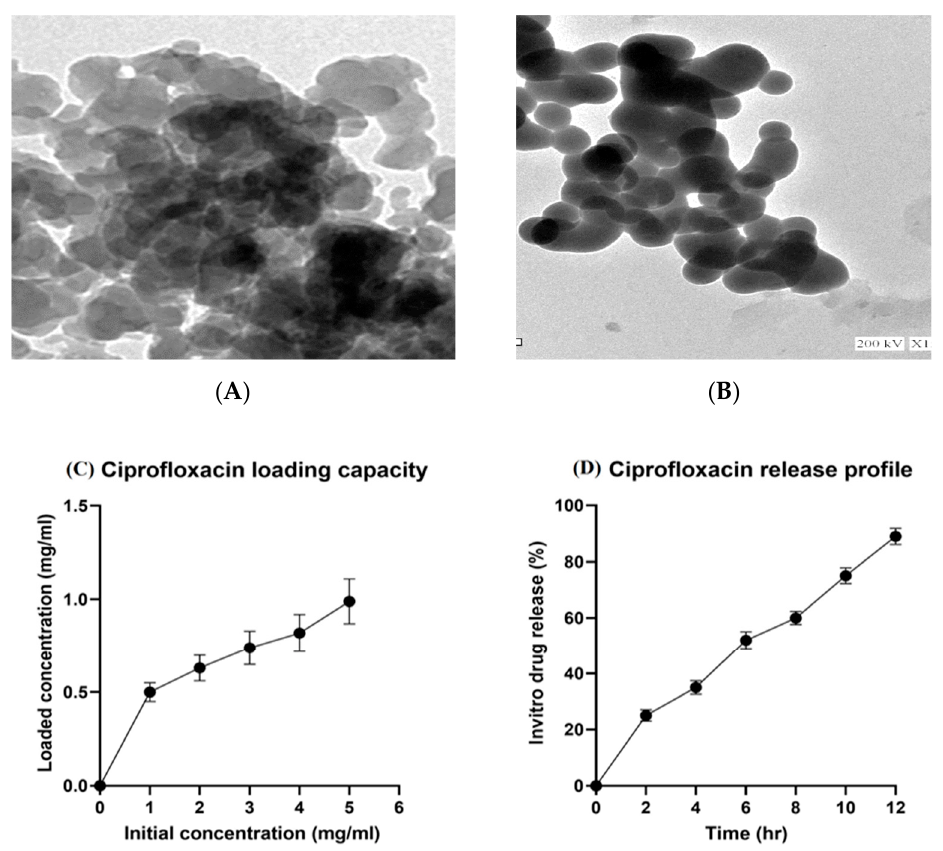
Figure 1. ( A,B ) Characterization of CIP–MSNs NPs by transmission electron microscopy (TEM); ( C ) Ciprofloxacin loading amount in relation to initial drug concentration (mg/mL); ( D ) percentage of ciprofloxacin in vitro release from CIP–MSNs over 12